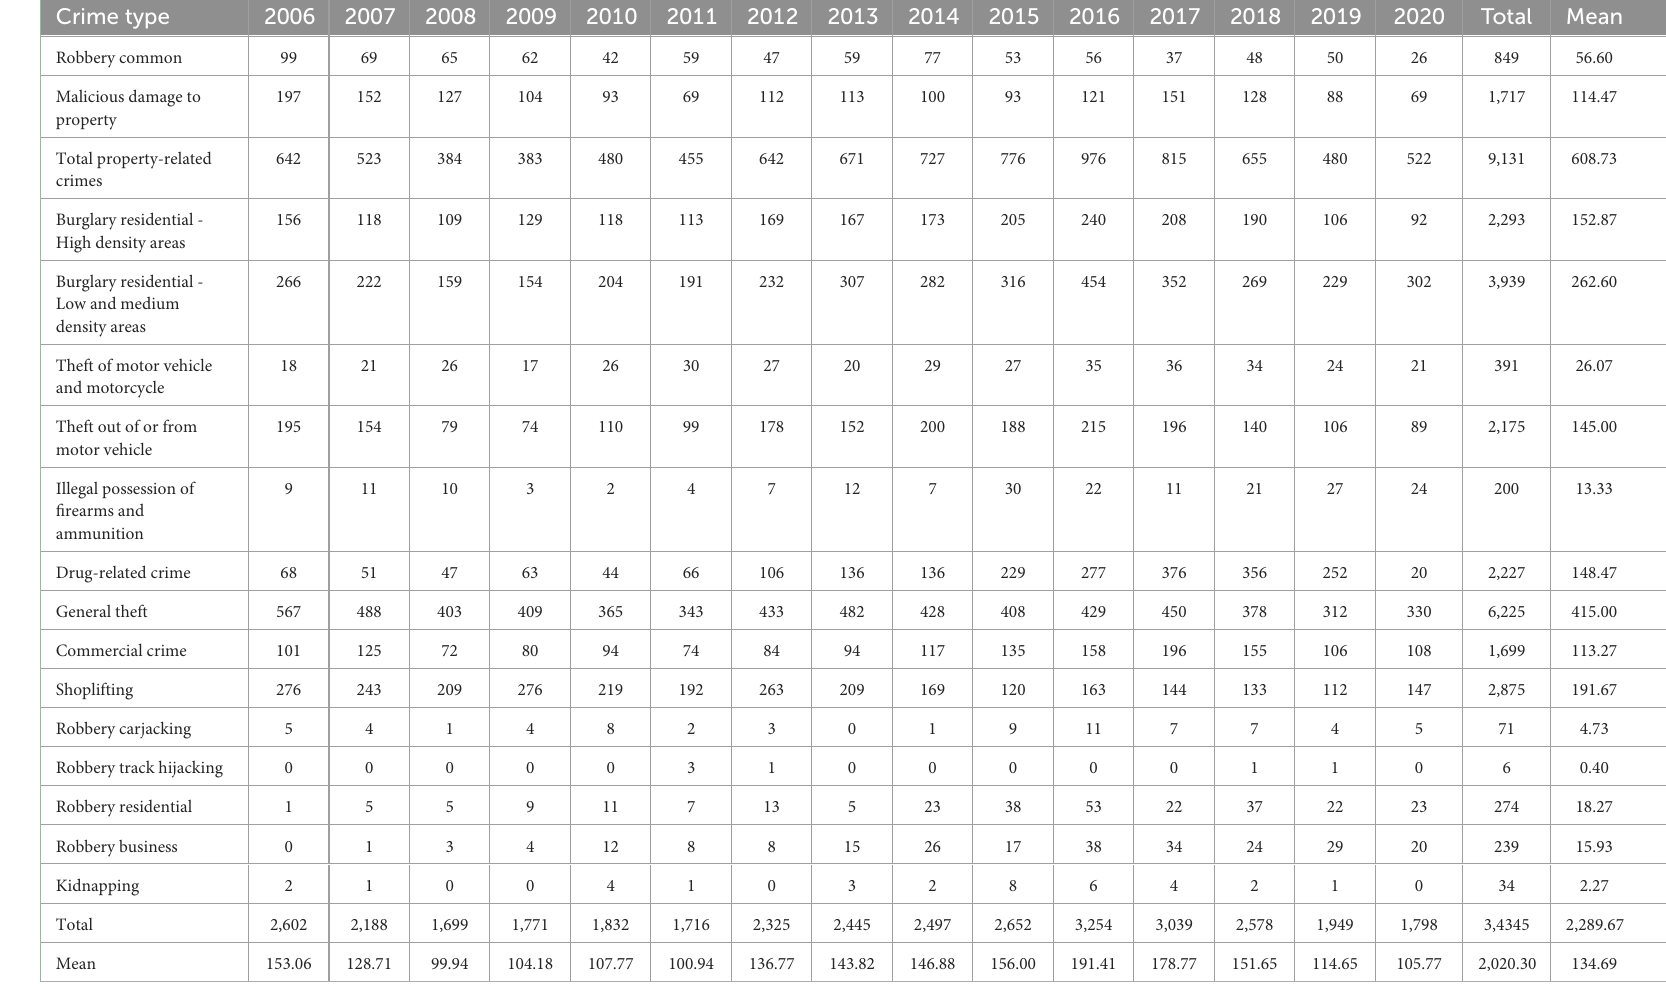
TABLE 1 Trend analysis of crime in Makhado